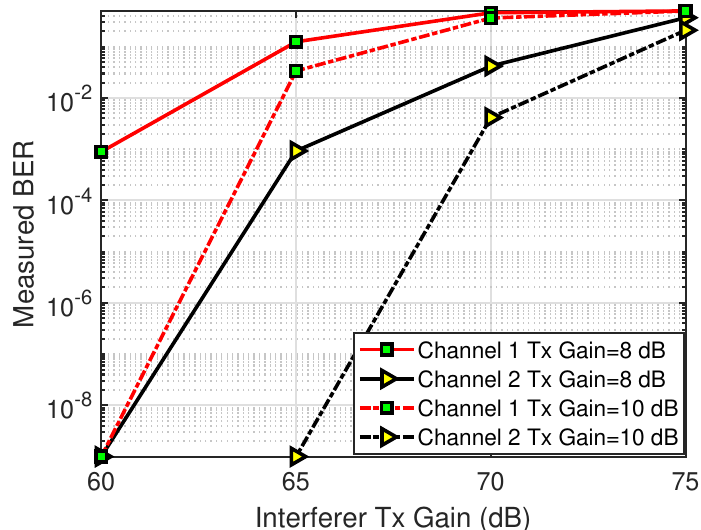
Figure 8. Measured BER of USRP channel 1 and USRP channel 2 in the presence of different MIMO interference